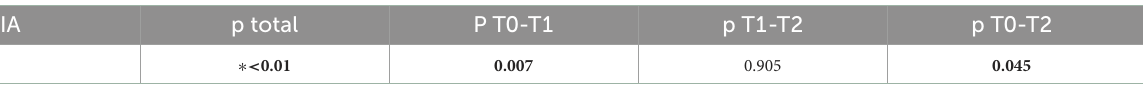
TABLE 6 Simple main effect for time for MAIA